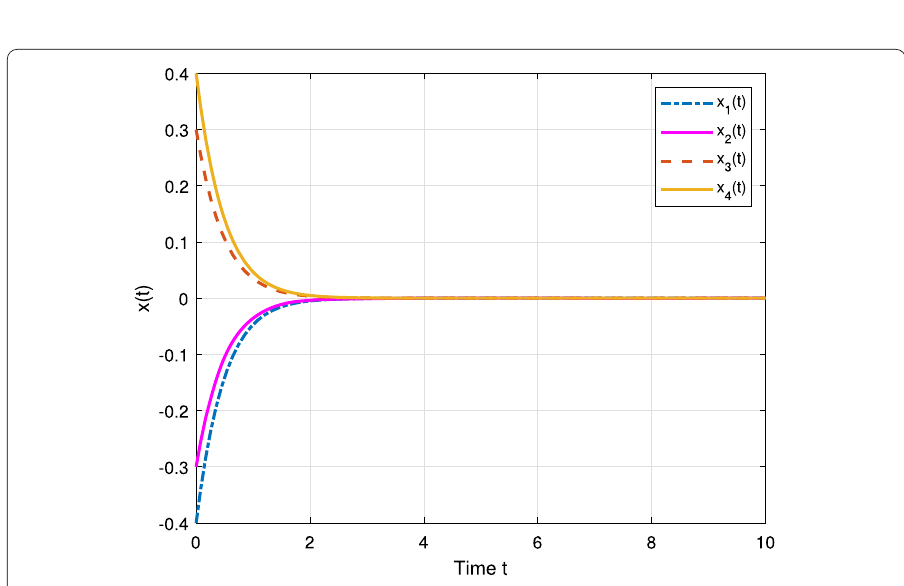
Figure 8 State responses of x ( t ) for the GNNs with u ( t ) (47) in Example